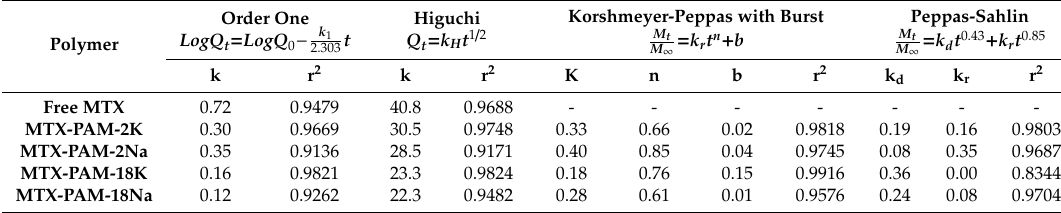
Table 3. Fitting parameters of several kinetic models for MTX release.